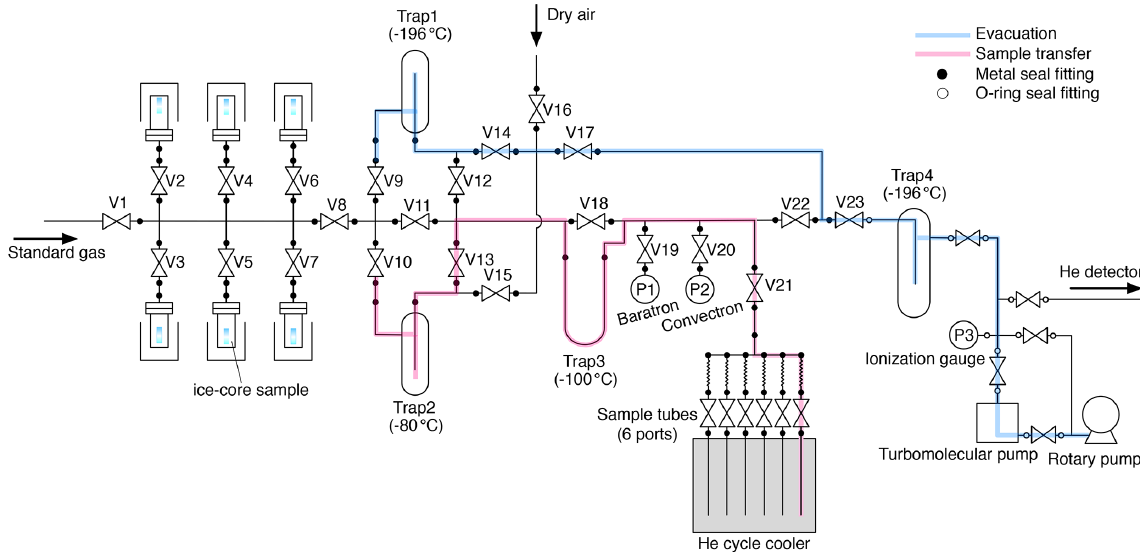
Figure 1. Schematic diagram of the wet-extraction